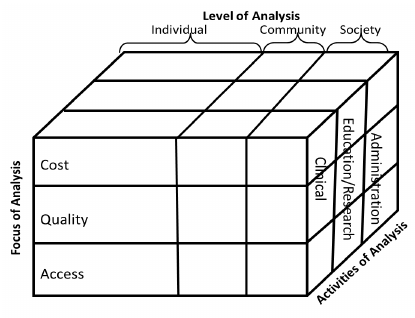
Figure 2. Comprehensive model for evaluating telemedicine [11].